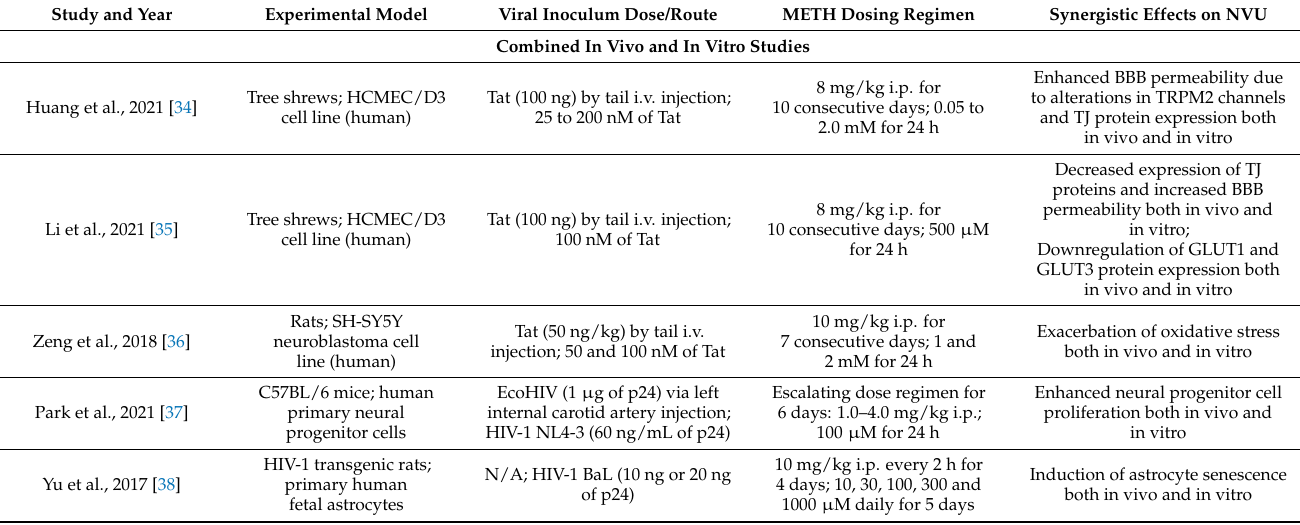
Table 1. A summary of recent studies showing that HIV-1 infection and methamphetamine (METH) use synergistically impair the neurovascular unit